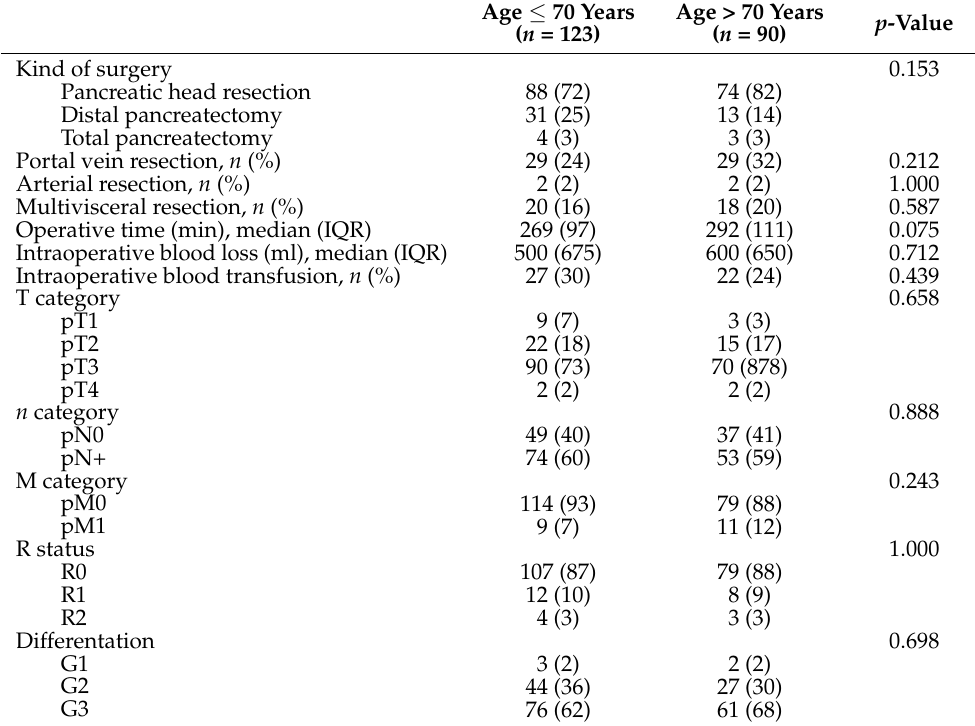
Table 2. Surgical and histopathological details of patients undergoing pancreatic resection for pancreatic ductal adenocarcinoma stratified to age ( ≤ 70 years vs. >70 years).